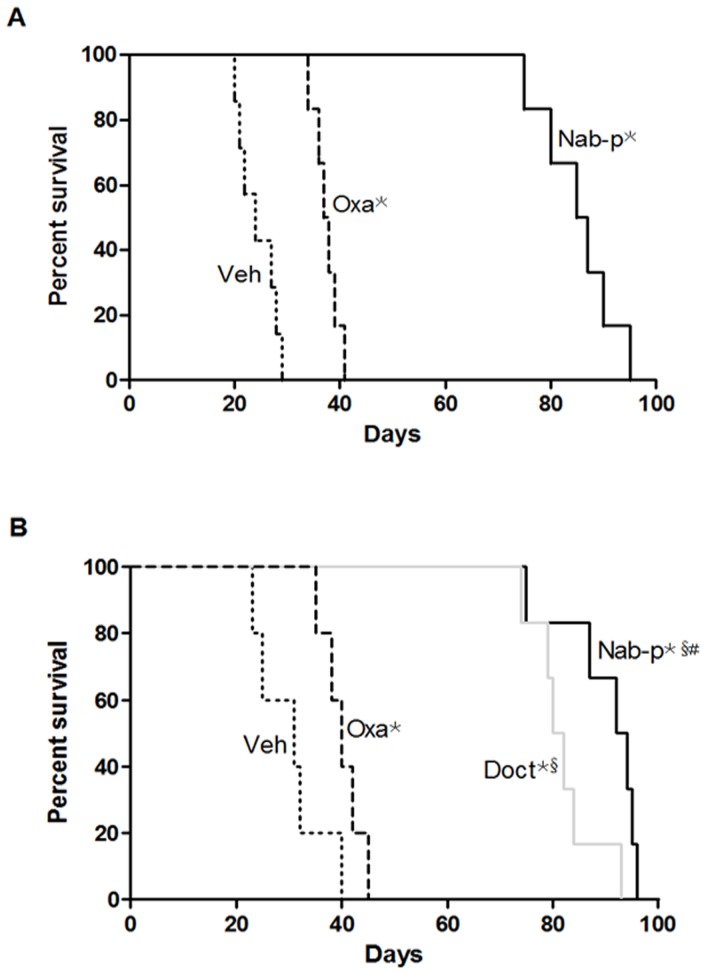
Effects of nab-paclitaxel therapy on the overall survival of mice.(A) Antitumor effect of nab-paclitaxel compared with oxaliplatin. SNU cells (40×106) were injected intraperitoneally into SCID mice, followed by treatment after 2 weeks with nab-paclitaxel (10 mg/kg, 2 times a week) and oxaliplatin (5 mg/kg, 2 times a week) for 2 weeks. (B) Antitumor effect of nab-paclitaxel compared with oxaliplatin and docetaxel. SNU cells (40×106) were injected intraperitoneally into SCID mice, followed by treatment after 2 weeks with nab-paclitaxel (10 mg/kg, 2 times a week), oxaliplatin (5 mg/kg, 2 times a week), or docetaxel (3 mg/kg, 2 times a week) for 2 weeks. The curve represents the animal survival time from the beginning of therapy. Symbol * represents significant difference compared with vehicle control (p<0.05), symbol § represents significant differences compared with oxaliplatin (p<0.05), and symbol # represents significant differences compared with docetaxel (p<0.05).